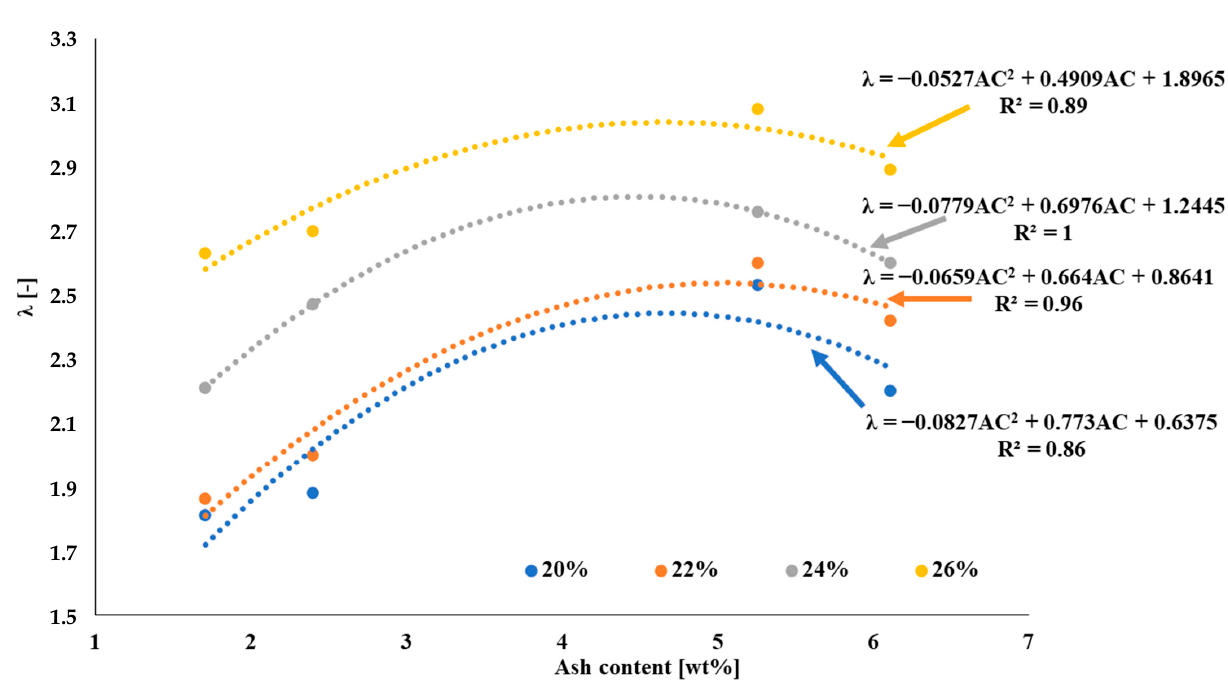
Figure 5. Dependence of the excess air coefficient λ from the fuel ash content (AC). The efficiency of combustion can be represented by the carbon conversion ratio. The not oxidized carbon remains in ashes; therefore, the energy of this reaction can be consid- ered lost during the process. Table 4 represents the calculated carbon conversion factor (C conv ) given as the percentage of carbon being oxidized during combustion. The combus- tion efficiency of P1 and P2 pellets is found to be strongly affected by the air coefficient. For instance, a λ increase from 2.53 to 3.08 resulted in a 9% increase in the C conv of P1 pellets. This phenomenon can be associated with the high ash content of P1 and conse- quently limits the contact of combustibles and air. Moreover, an increase in the air supply penetrate the fuel particles improving oxidation.